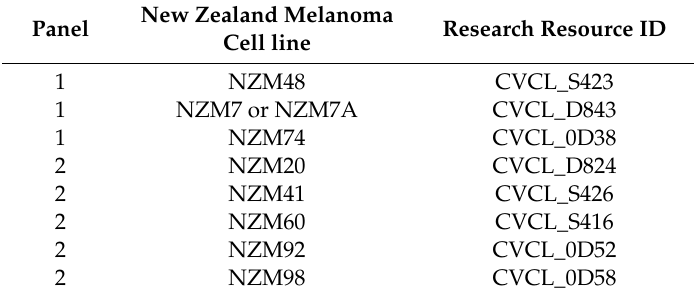
Table A2. List of human-derived New Zealand Melanoma (NZM) cell types. New Zealand Melanoma Panel Cell